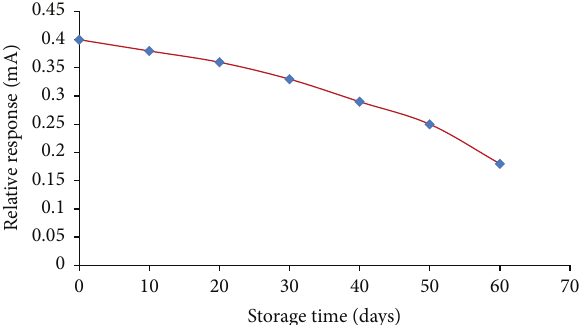
Figure 14: Storage stability of the present method.